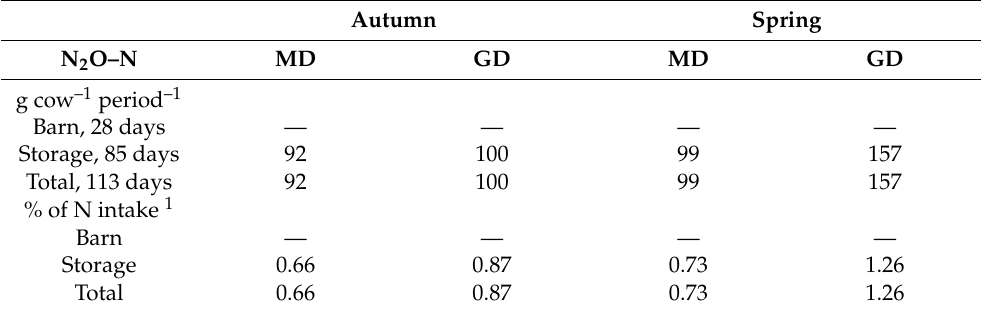
Table 5. Nitrous oxide (N 2 O–N) cumulative emissions from the straw-based deep litter produced by dairy cows fed with a maize-silage-based diet (MD) or a grass-based diet (GD) in autumn or spring. Autumn